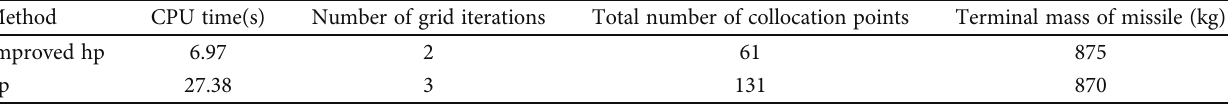
Table 4: Comparison of mesh re fi nement